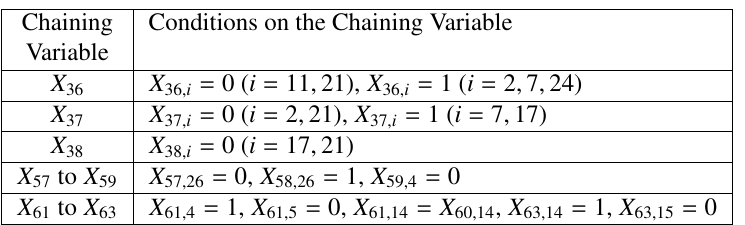
Table 8: The Conditions of Steps 36-38, 57-64 in Left Branch Chaining Conditions on the Chaining Variable